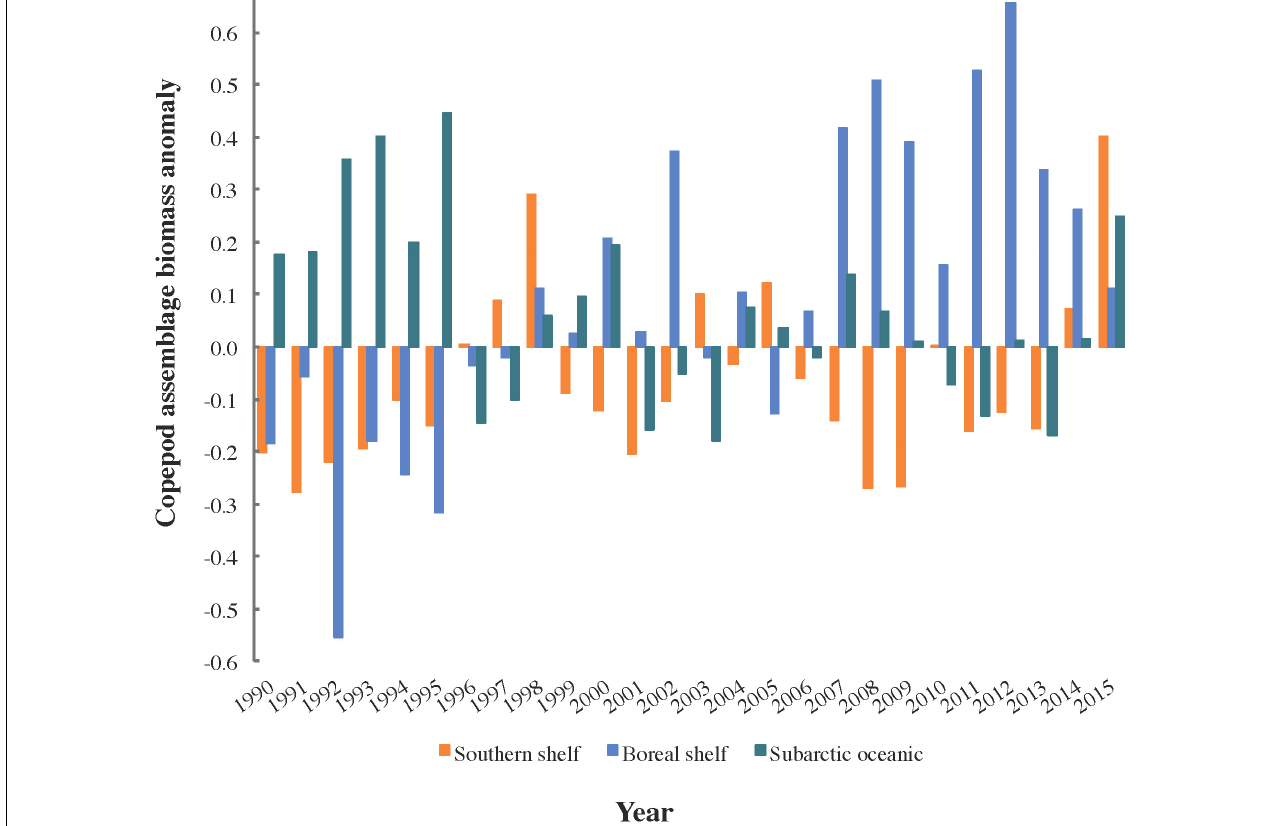
FIGURE 2 | Trends in (A) estimated natural mortality ( M ) for five Pacific herring stocks (DFO, 2016) and (B) biomass anomalies for three copepod assemblages off northwest Vancouver Island, 1990–2015 (Galbraith and Young, 2017).